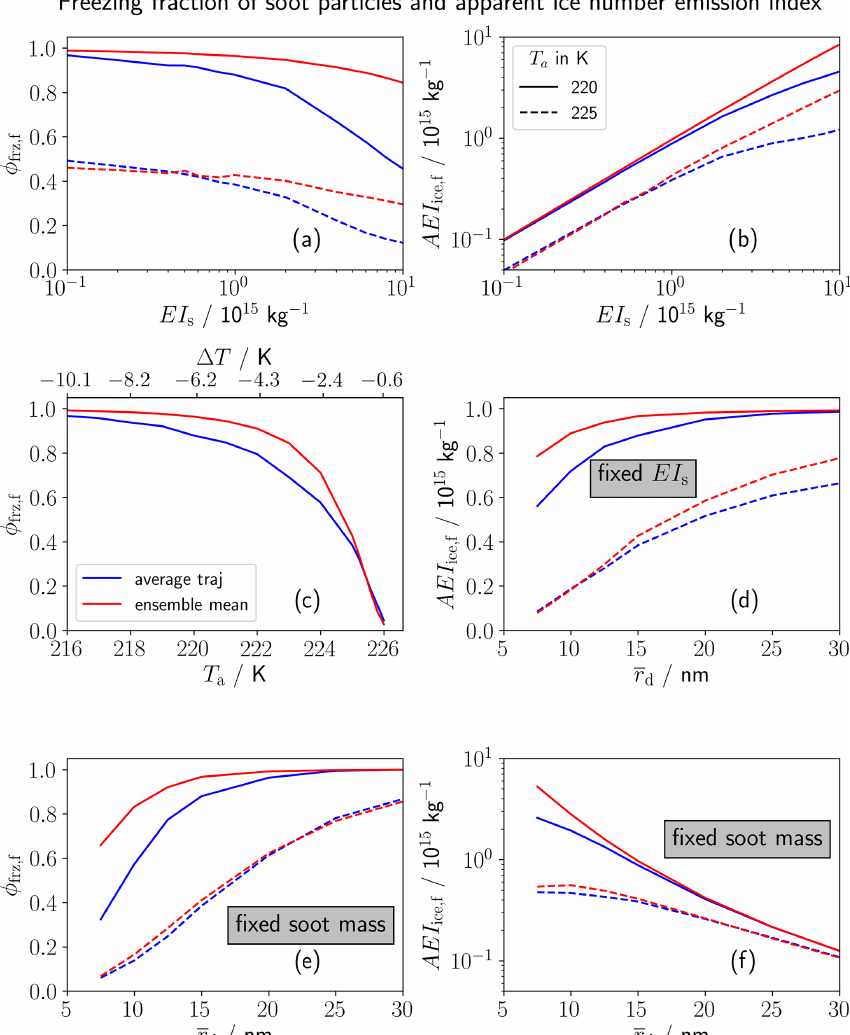
Figure 5. Fraction of soot particles freezing to ice crystals φ frz,f ( a , c and e ) and apparent ice number emission index A EI ice,f ( b , d and f ) at a plume age of 2s depending on EI s (a, b) , ambient temperature T a in panel (c) (where the axis on the top additionally shows the temperature difference to the SA threshold, (cid:49)T = T a − (cid:50) G ) and on the geometric-mean soot core radius r d in panels (d–f) . In all but panel (c) , results are shown for T a of 220K (solid) and 225K (dashed), indicated by the legend in the top right panel. In panel (d) , EI s is fixed to the baseline case, while in panels (e) and (f) , the total soot mass is fixed (implying an adaptation of EI s ∝ r − 3 and the blue lines the average traj